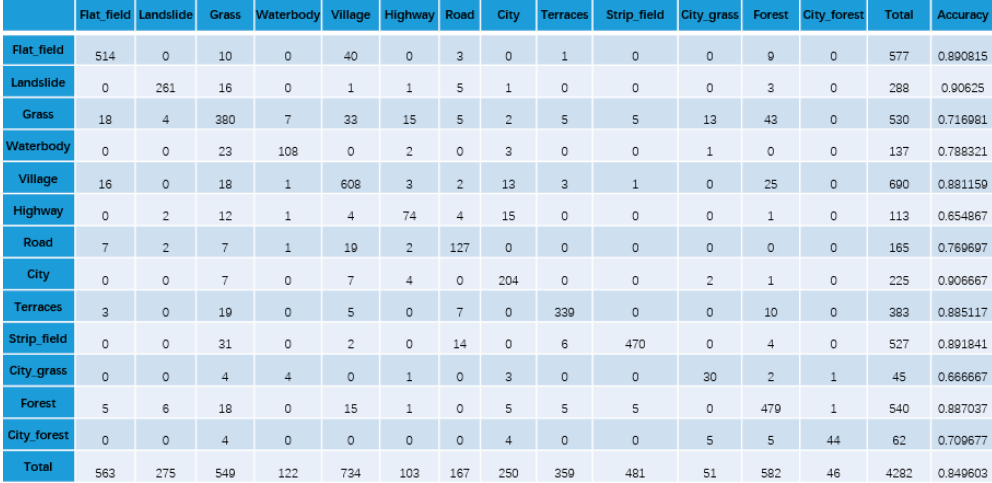
Figure 20. The object-based confusion matrix of the KGGCN model.